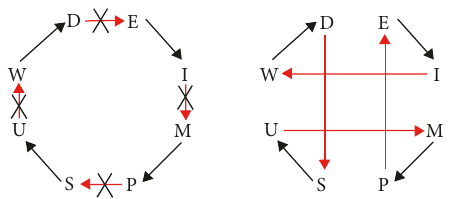
Figure 4: An example of the double-bridge kick operator on eight attractions that removes edges (𝐷, 𝐸),(𝐼, 𝑀),(𝑃,𝑆) , and (𝑈, 𝑊) and replaces them with edges (𝐷, 𝑆),(𝑃, 𝐸),(𝐼, 𝑊) , and (𝑈,𝑀)